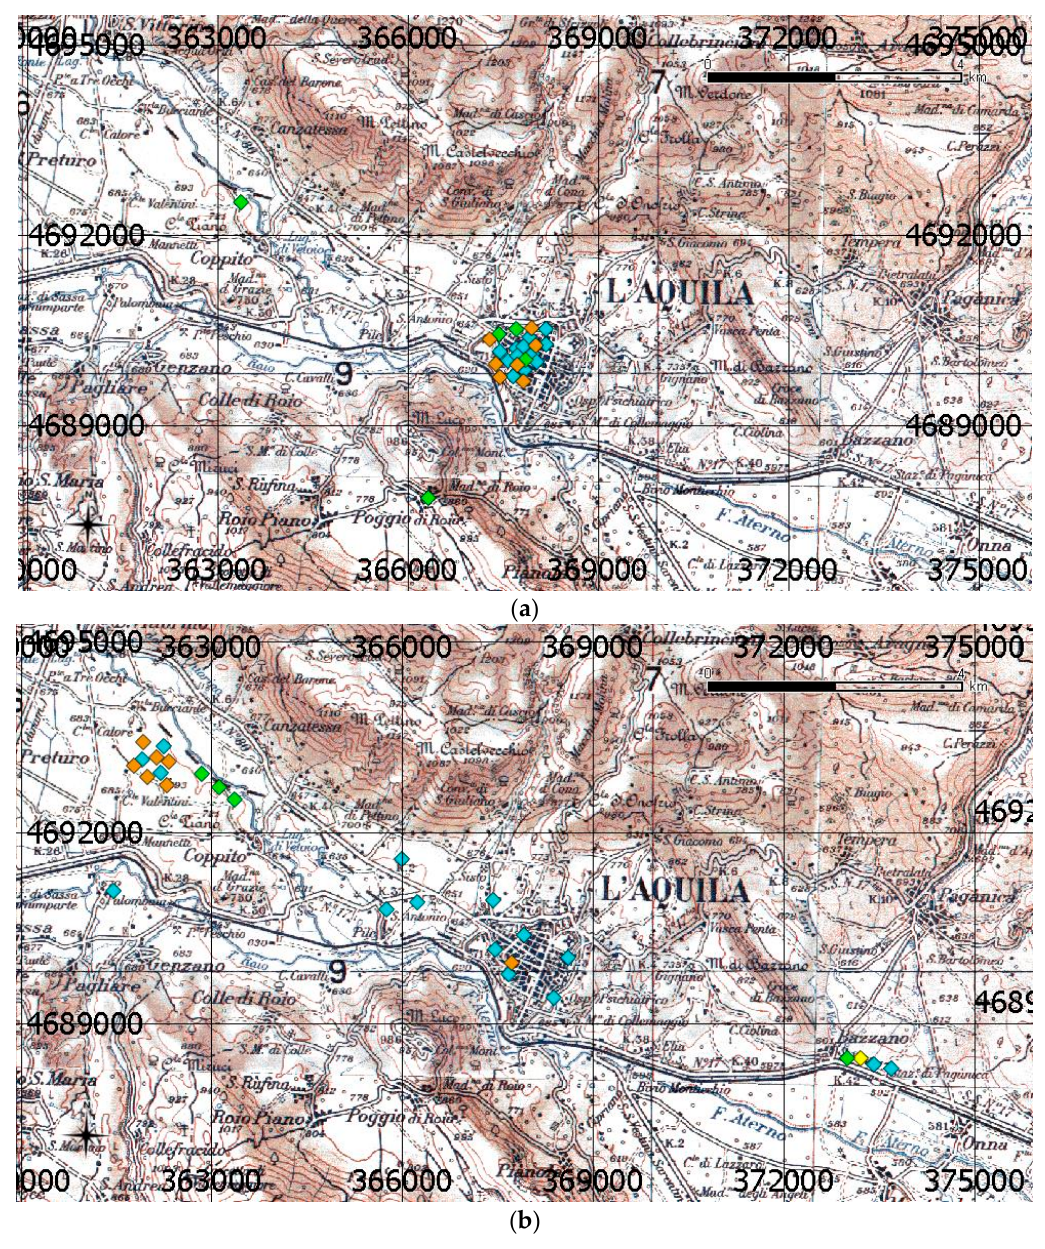
Figure 2. L’Aquila, before ( a ) and after ( b ) the main seismic event: Overlapped grid is Universal Transverse Mercator Projection (UTM) WGS84/ETRF00. Scale bar (upper right) is 4 km, and the north-pointing arrow (lower left) indicates the geographic north.